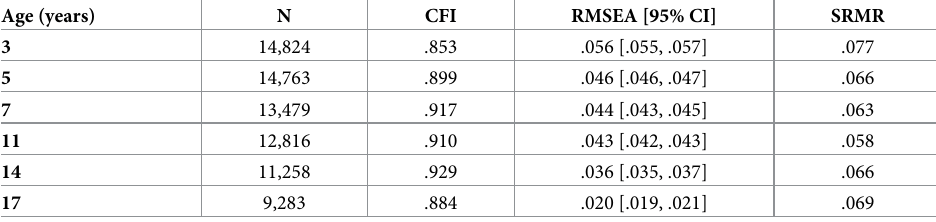
Table 2. Model fit statistics for confirmatory factor analyses.